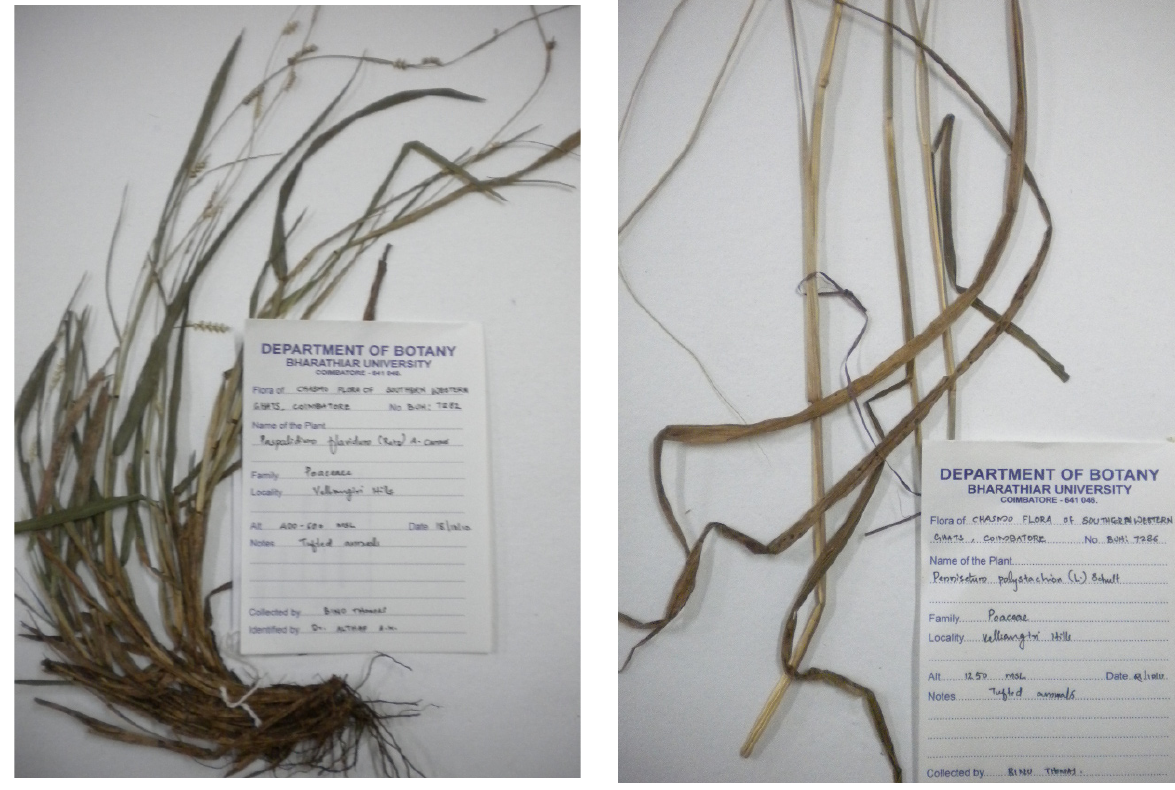
Image 26. Paspalidium flavidum (Retz.) A. Camus Image 27. Pennisetum polystachion (L.)